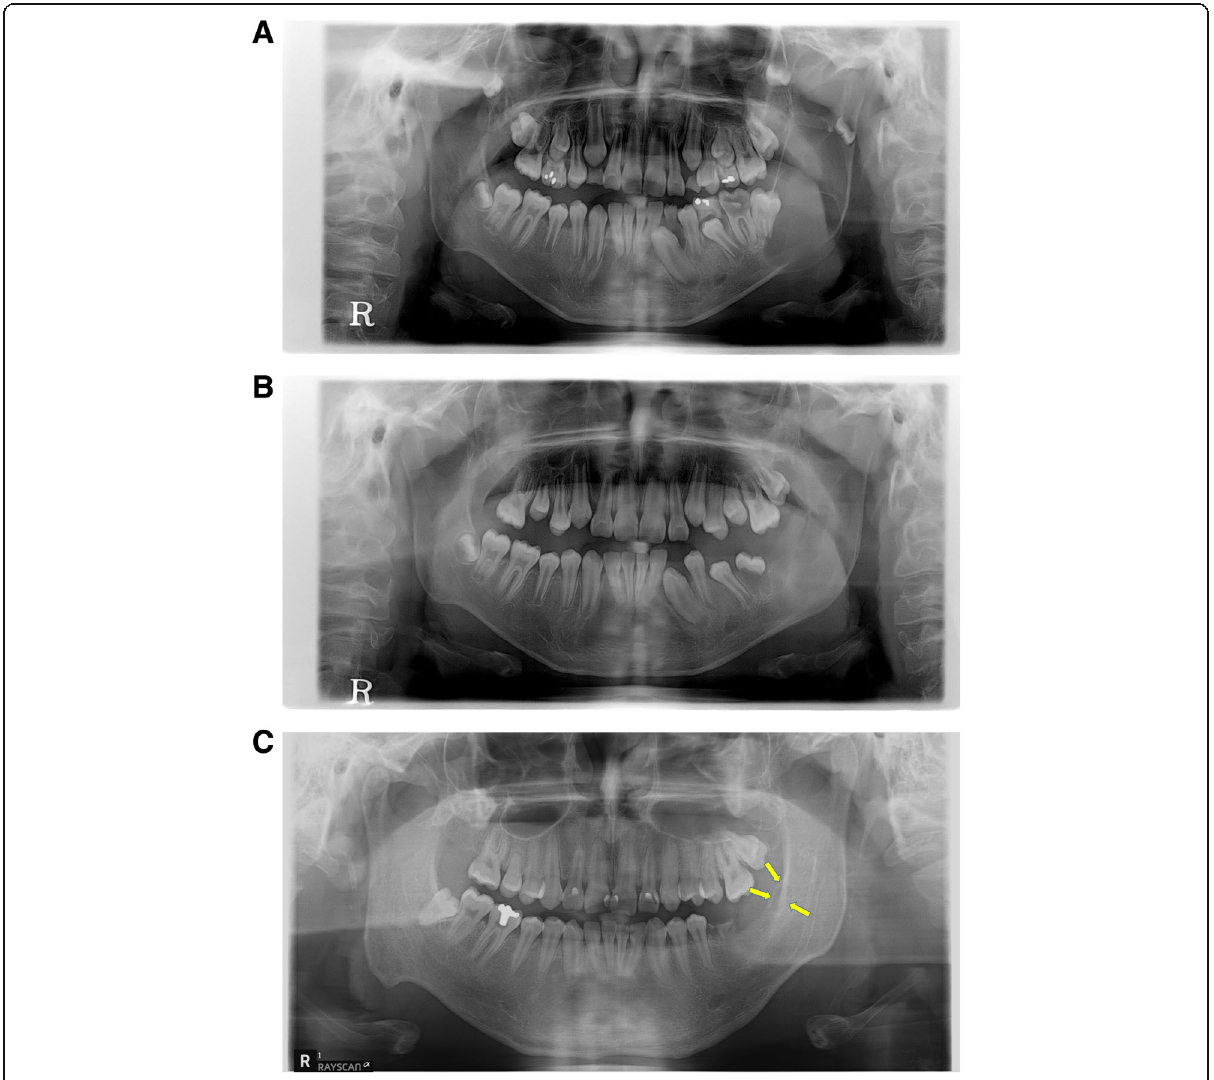
Fig. 1 The example for recurrence case of OKC. a Pre-op. panoramic view. b Post-op. panoramic view. c Recurrence was observed after the initial enucleation surgery 10 years